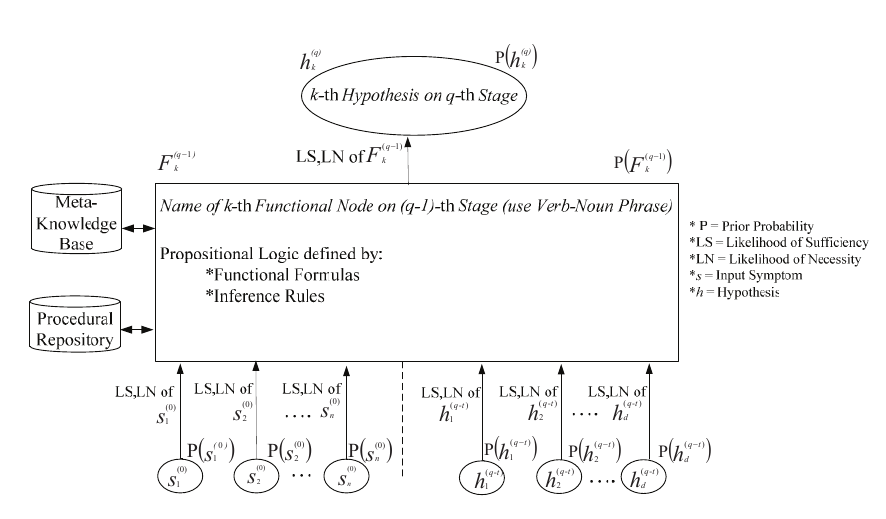
Figure 1. Generalized Bayesian inference nets